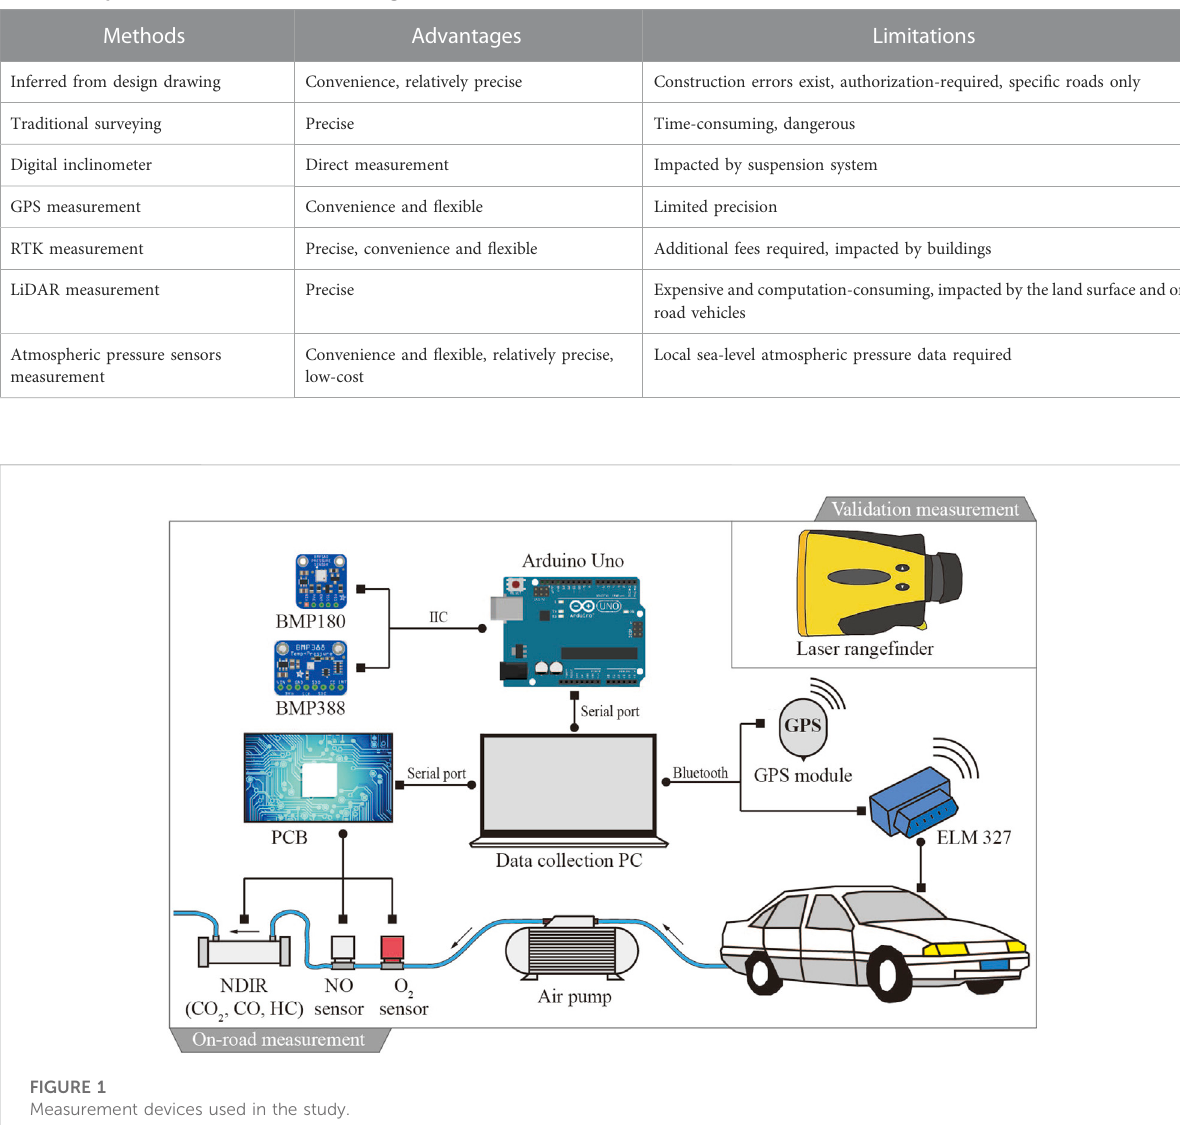
TABLE 1 Comparison of several methods of road grade measurement.